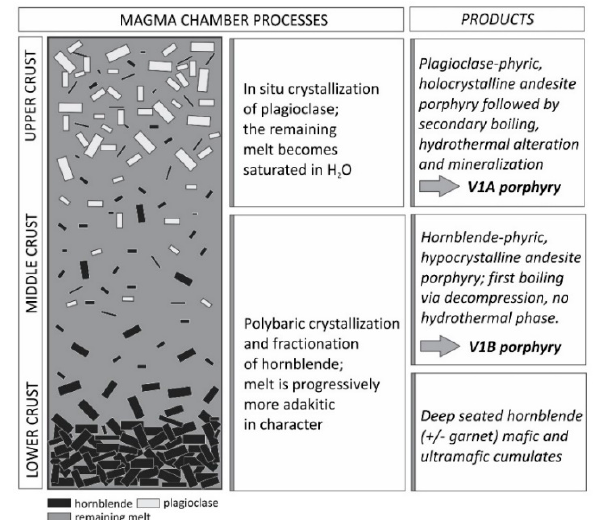
Figure 8. Not-to-scale sketch illustrating polybaric fractional crystallization of a mafic/intermediate magma initially rich in water, sulphur, chlorine and characterized by high oxygen fugacity; on the right-hand side, depth-dependent crystallization sequences are described.